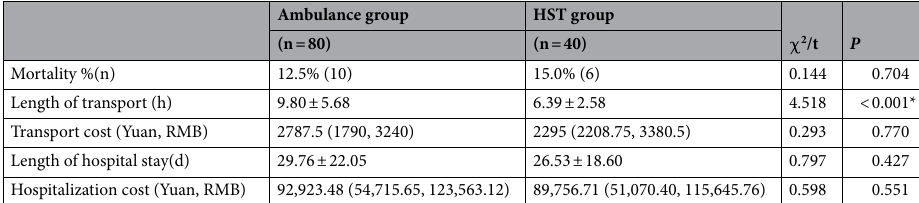
Table 2. The Primary and Secondary outcomes of ambulance and HST groups. * p <